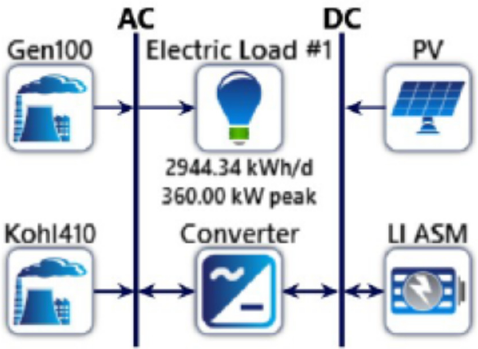
Figure 6. Scheme of the hybrid system with limited BESS solution.